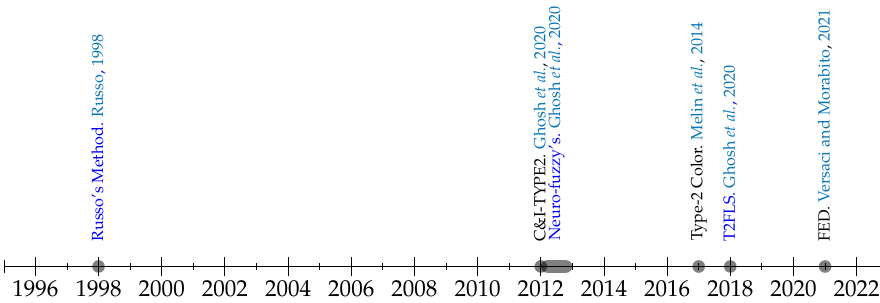
Figure 3. Chronology of fuzzy methods presented in this paper